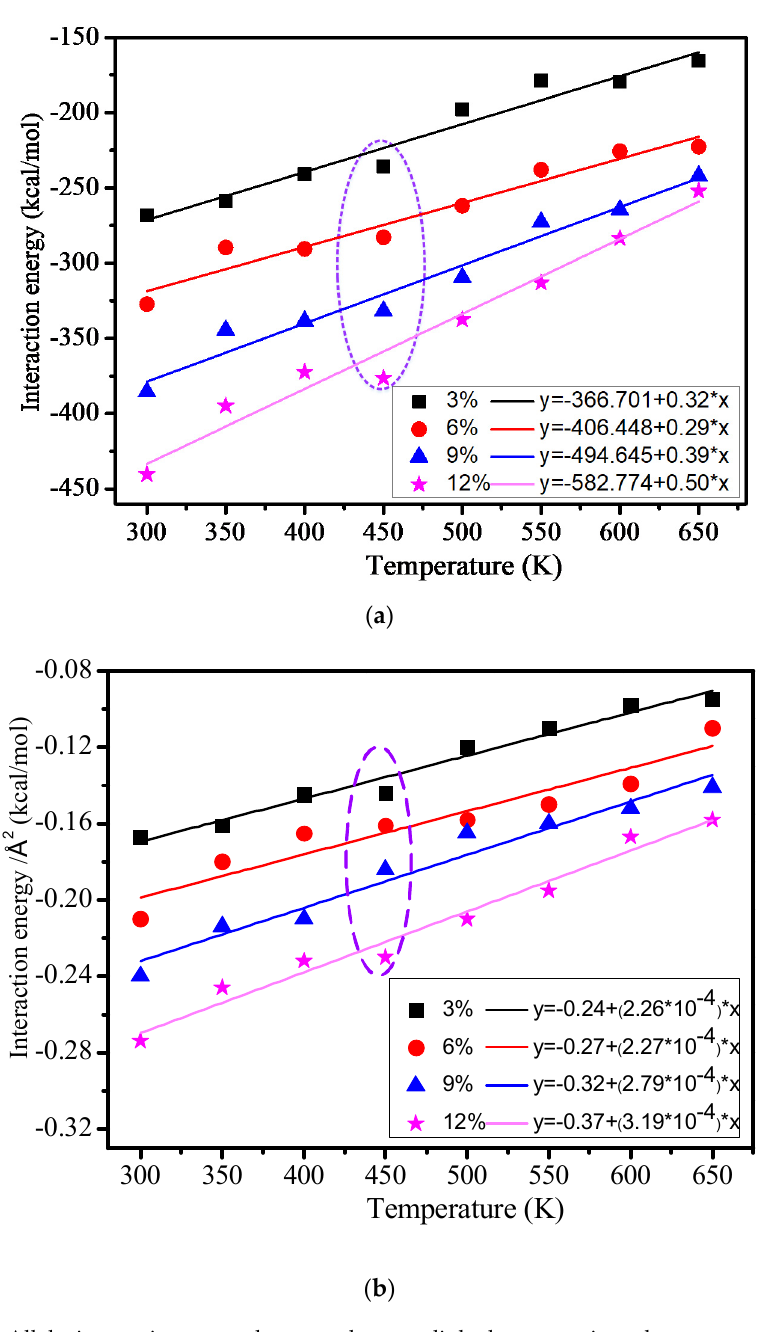
Figure 9. ( a ) All the interaction energy between the cross-linked epoxy resin and nanocomposite models; ( b ) Interaction energy between cross-linked epoxy resin and nanocomposite models in square angstrom. A and B are constant, respectively. The result shows that the high temperature will destruct the